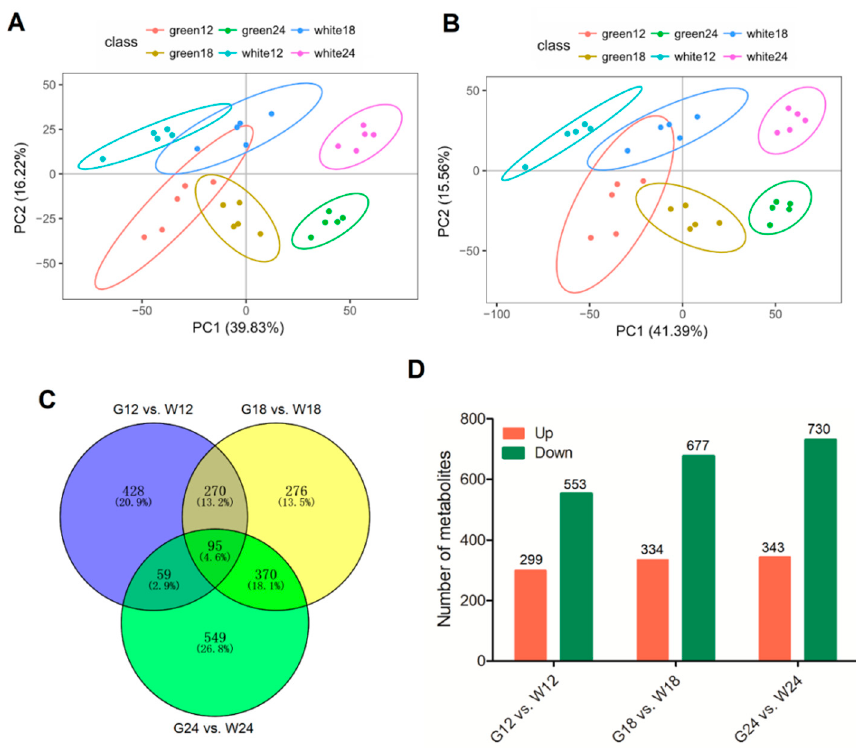
Figure 1. Comparison of metabolites from di ff erent developmental stages of cotton fibers. ( A ) Principal component analysis (PCA) score plot derived from metabolite ions acquired using the electrospray ionization positive ion mode (ESI + ). ( B ) PCA score plot derived from metabolite ions acquired using the electrospray ionization nagative ion mode (ESI − ). ( C ) Venn diagram showing di ff erent metabolites identified between green-colored fiber (GCF) and white-colored fiber (WCF). ( D ) The number of up- (red) and down-regulated (green) metabolites in each comparison.